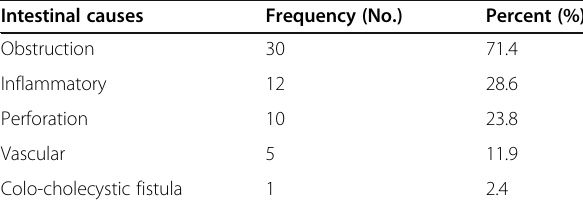
Table 2 Distribution of patients according to gastric causes Gastric causes Frequency (No.) Percent (%) Gastric obstruction 5 62.5